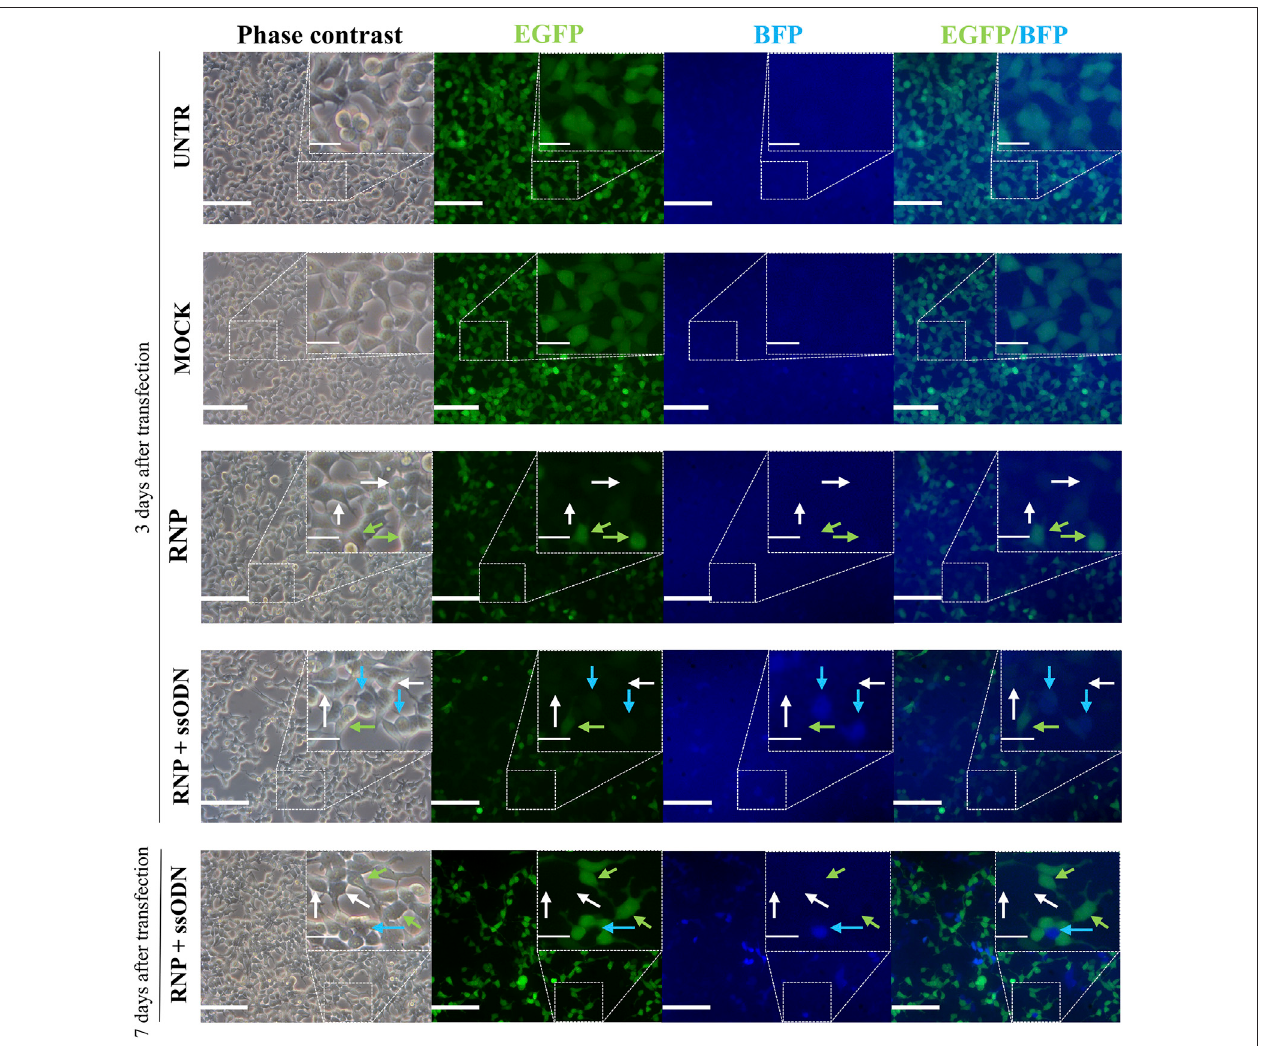
FIGURE 2 | Visual evaluation of gene editing in HEK293T cells. Three days after transfection, gene knockout (EGFP − /BFP − ) and gene conversion (EGFP − /BFP + ) wereobservedundera fl uorescencemicroscope.Thiswasevenbetterdetectable7 daysaftertransfection.Geneknockout(EGFP − /BFP − ,greyarrows)wasdetectedin RNPandRNP+ssODN,butabsentintheMOCKandUNTRcontrol.Geneconversion(EGFP − /BFP + ,bluearrows)wasonlyobservedafterco-lipofectingssODNs(RNP + ssODN). Unaffected cells (EGFP + /BFP − , green arrows) were detected in all conditions. UNTR: negative control; MOCK: unloaded RNAiMAX; RNP: RNAiMAX loaded with RNP; RNP + ssODN: RNAiMAX loaded with RNP and ssODN. Scale bars represent 100 µm in whole pictures and 25 µm in inserts. Inserts depict higher magni fi cations of the boxed area in the